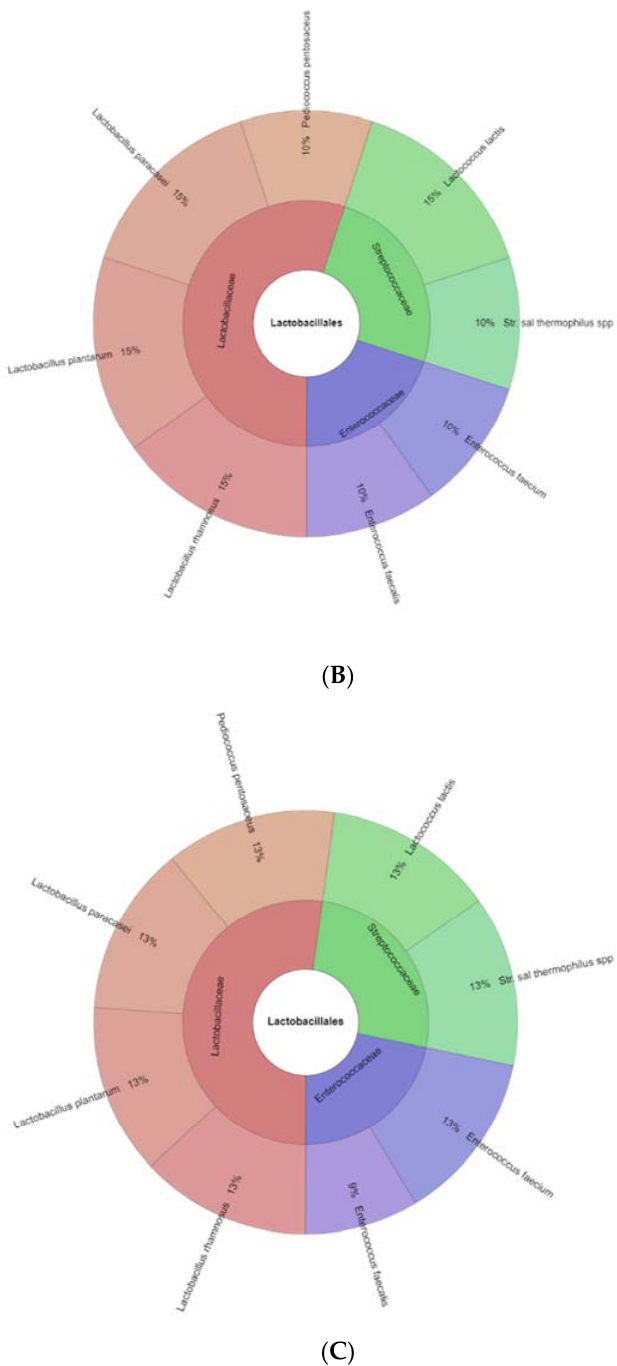
Figure 2. ( A – C ) Krona charts for the three groups A, B and C, automatically showing the taxonomic identification and relative abundance of bacterial species (outermost ring: species; middle ring: family; innermost ring: order).